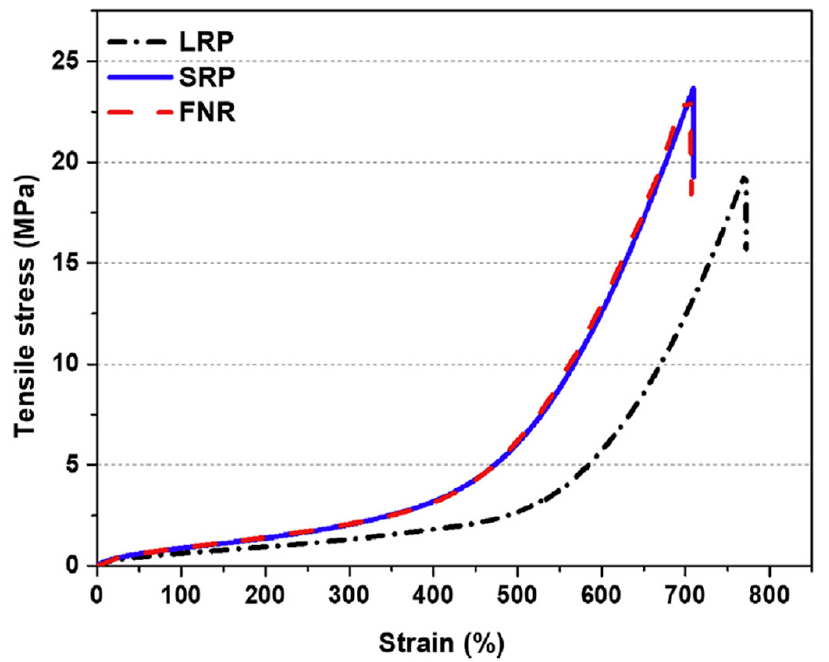
Figure 3. The stress–strain curves of rubber samples with/without non-rubber components [25]. Reprinted from [25], Copyright 2018, with permission from Elsevier.